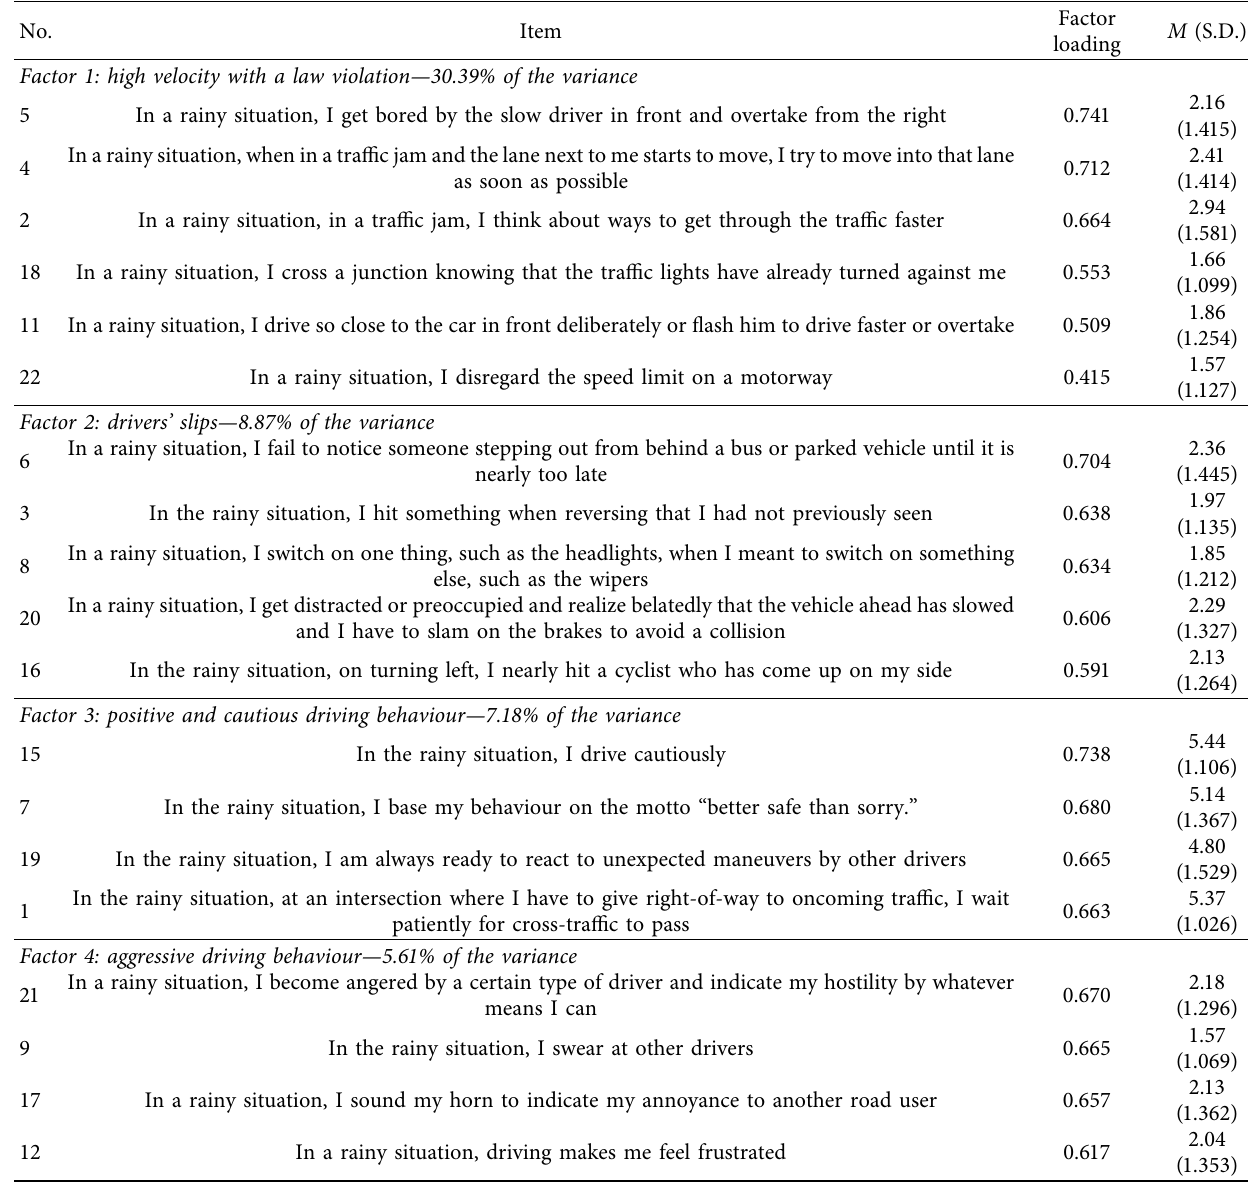
Table 3: Factor structure of the driving behaviour questionnaire under rainy